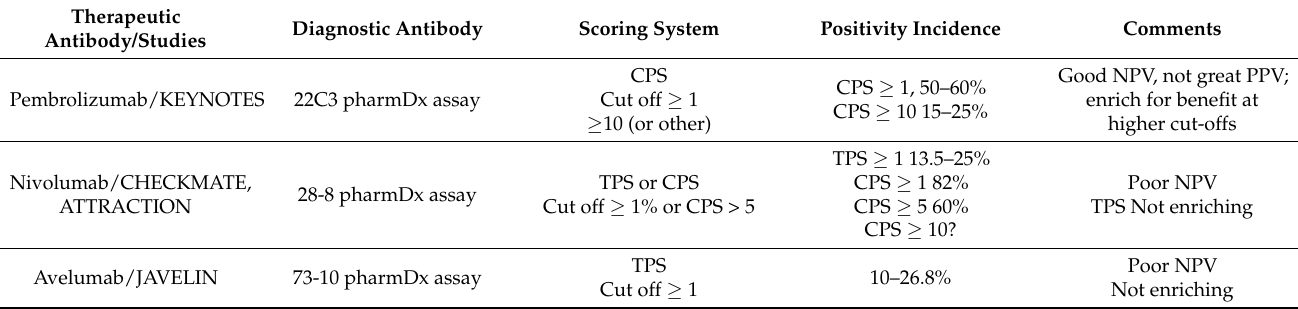
Table 3. PD-L1 diagnostic antibodies and scoring systems reported to date. Different studies, including KEYNOTES, CHECKMATES, ATTRACTION, JAVELINS, have used different diagnostic antibodies and scoring systems. In addition, these studies have used different positivity incidences based on CPS or TPS. The variability in positivity incidences will result in different NPV and PPV of response to ICI (CPS: combined positivity score; TPS: Tumor positivity score; NPV: Negative predictive value; PPV: positive predictive